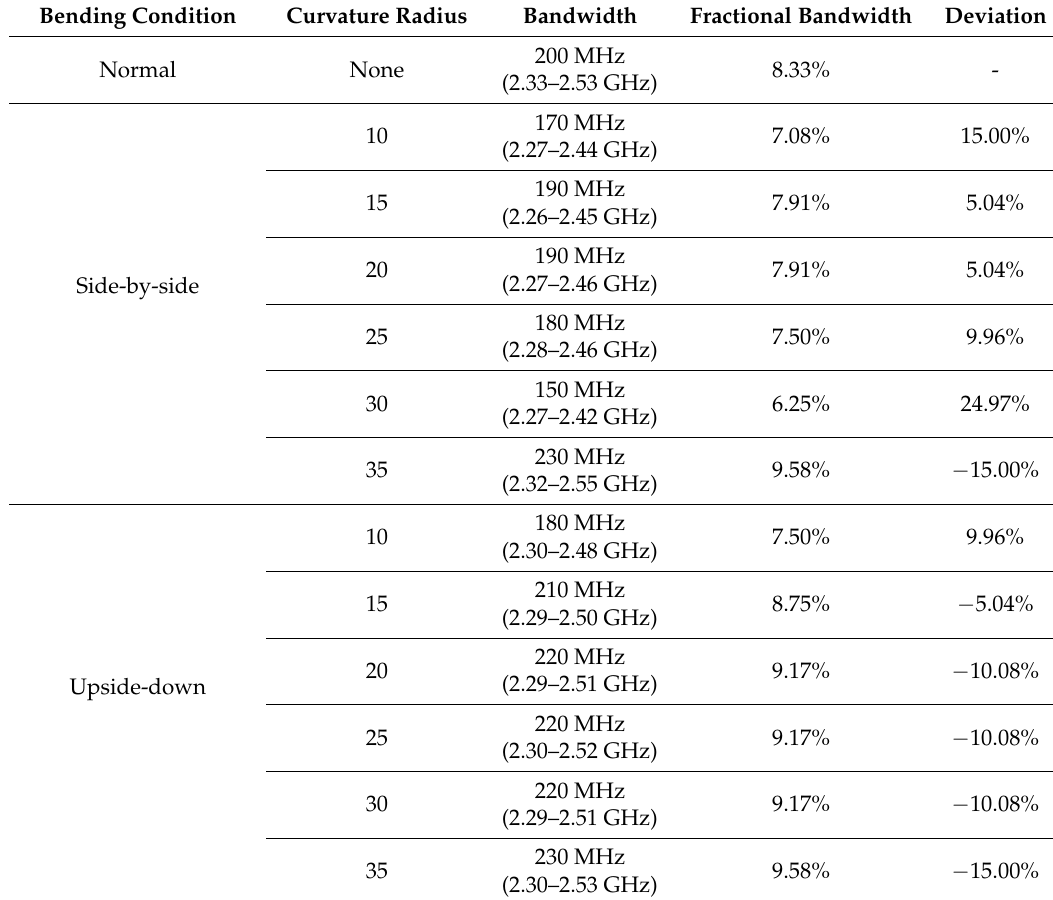
Table 2. Bending performance